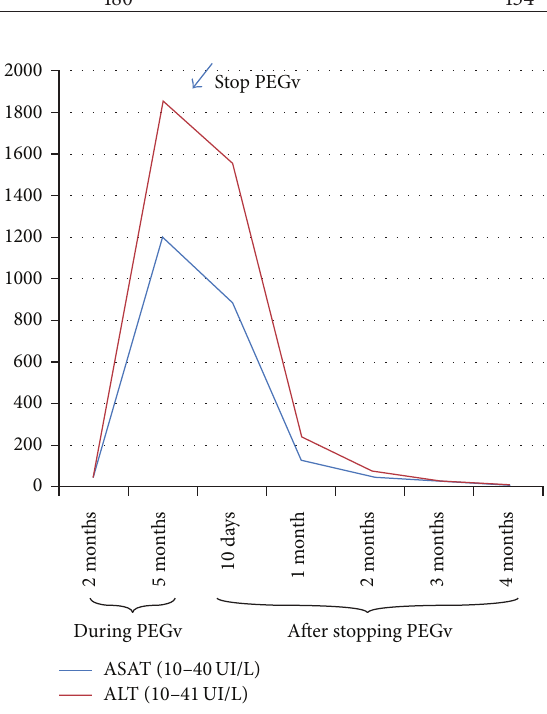
Blood cell count was normal: hematocrit 45%, hemoglobin: 15 grams/dL, and white blood cell count: 7100 cells/mcL with no eosinophilia. There were no changes in the normal pattern of coagulation tests and blood cell count during the course of the hepatic disease. The tests for viral and autoimmune hepatitis were negative. Elevated ferritin, iron, and transfer- ring saturation (TSAT) suggested probable hepatitis due to haemochromatosis. Liver and iron tests are shown in Table 1 and in Figure 1. The abdominal ultrasonography was normal. We decided to stop treatment with both lanreotide and